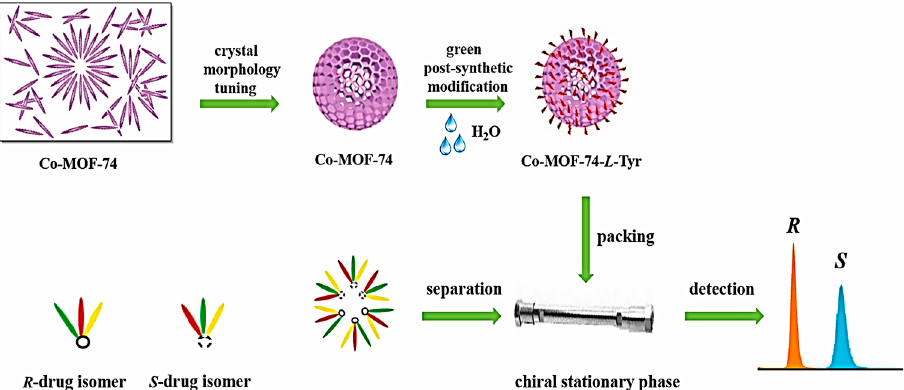
Figure 15. HPLC enantioseparation based on the application of chiral polyaniline-modified MOF